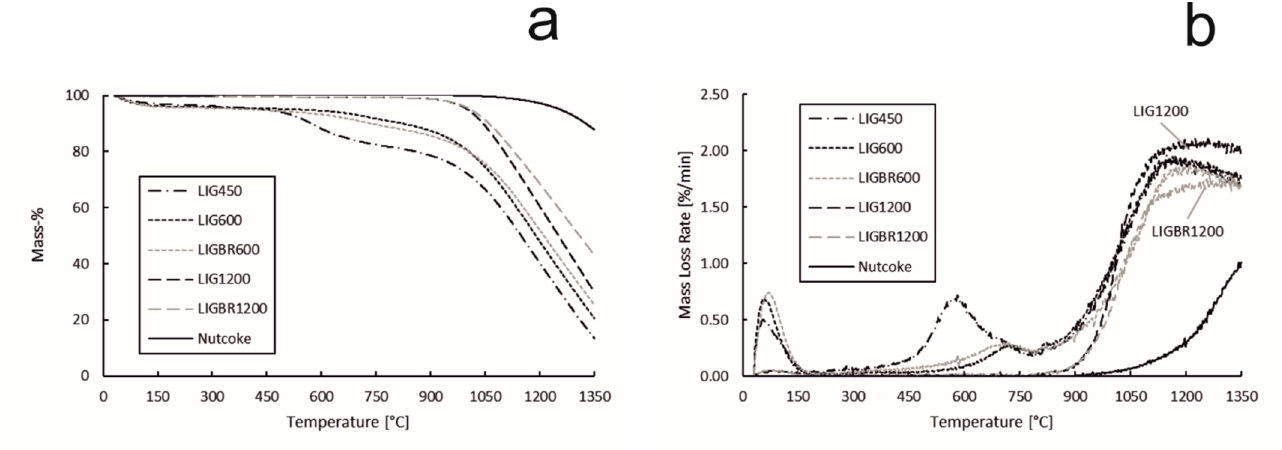
Figure 10. Reactivity of hydrolysis lignin chars and nut coke. ( a ) : sample mass percentage during the experiment; ( b ): mass loss rate of the samples during the experiment.